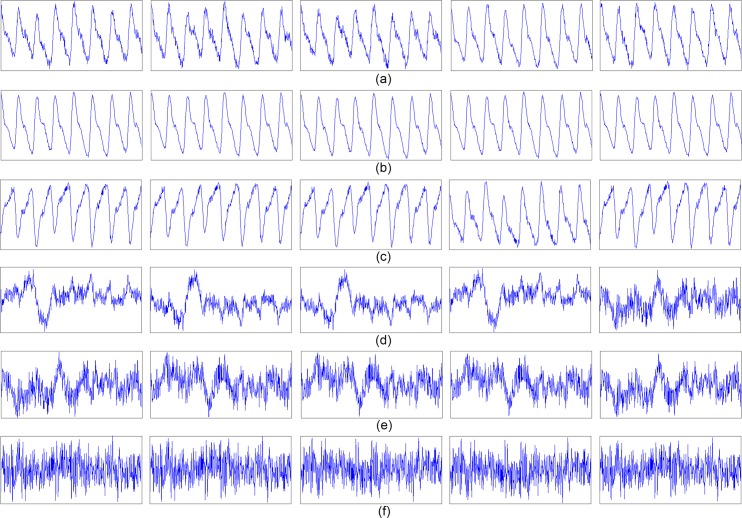
Multichannel pulse signal measured from DCRW and its singular decomposition value-based decomposed signals (channels 1 to 5 from left to right).(a) measured multichannel pulse signals, (b) decomposed signals u1σ1v1T, (c) decomposed signals u2σ2v2T, (d) decomposed signals u3σ3v3T, (e) decomposed signals u4σ4v4T, (f) decomposed signals u5σ5v5T.